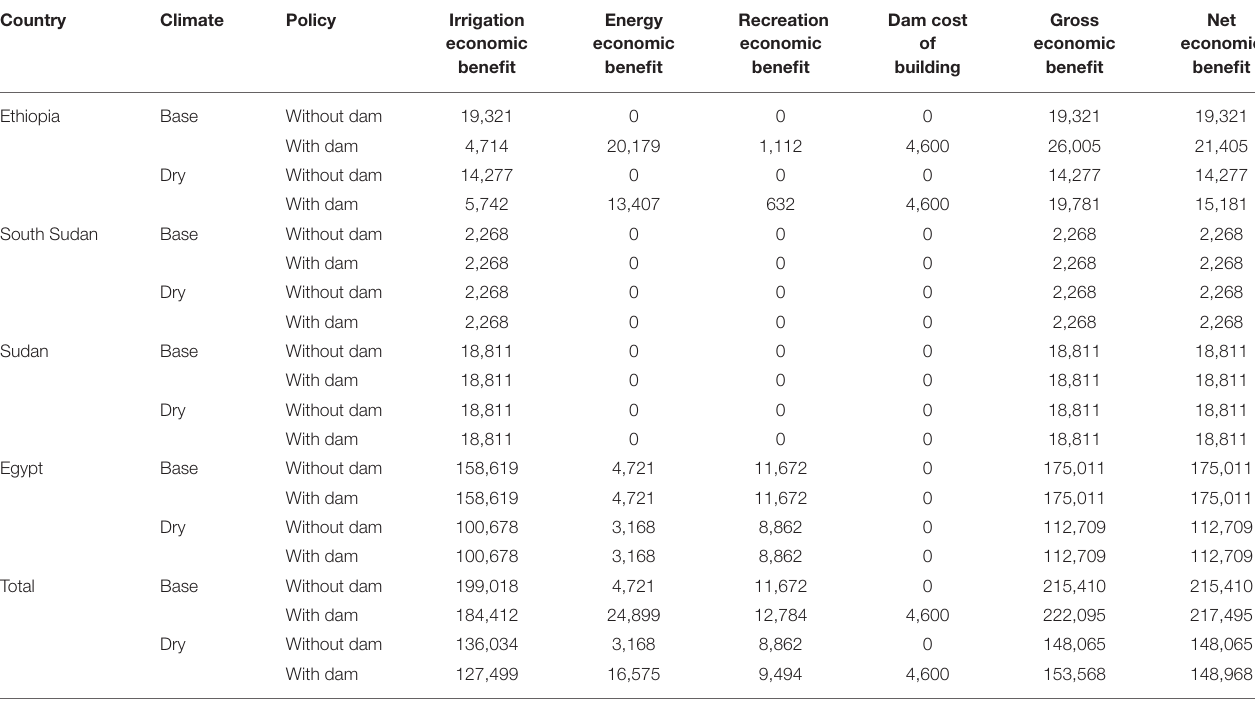
TABLE 4 | Hydroeconomic model results illustration—total economic benefits by country, policy, water supply scenario, and water use, Nile Basin (discounted net present value, $US Million, summed over 20 years). Country